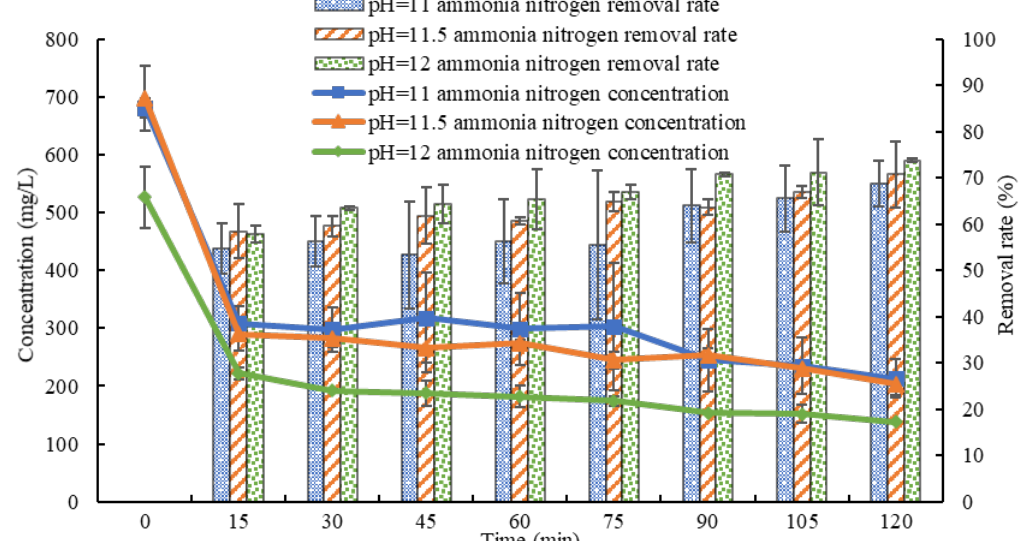
Figure 3. Variations in the concentration and removal rate of ammonia nitrogen with time in biogas slurry with different pH values.